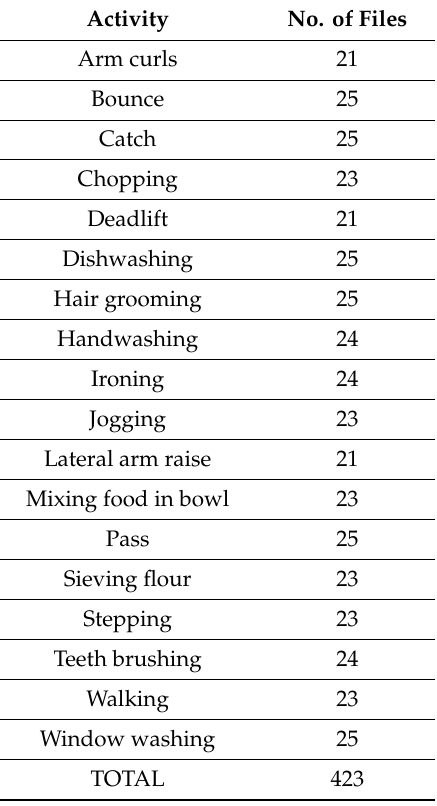
Table 4. Distribution of the data by activity.